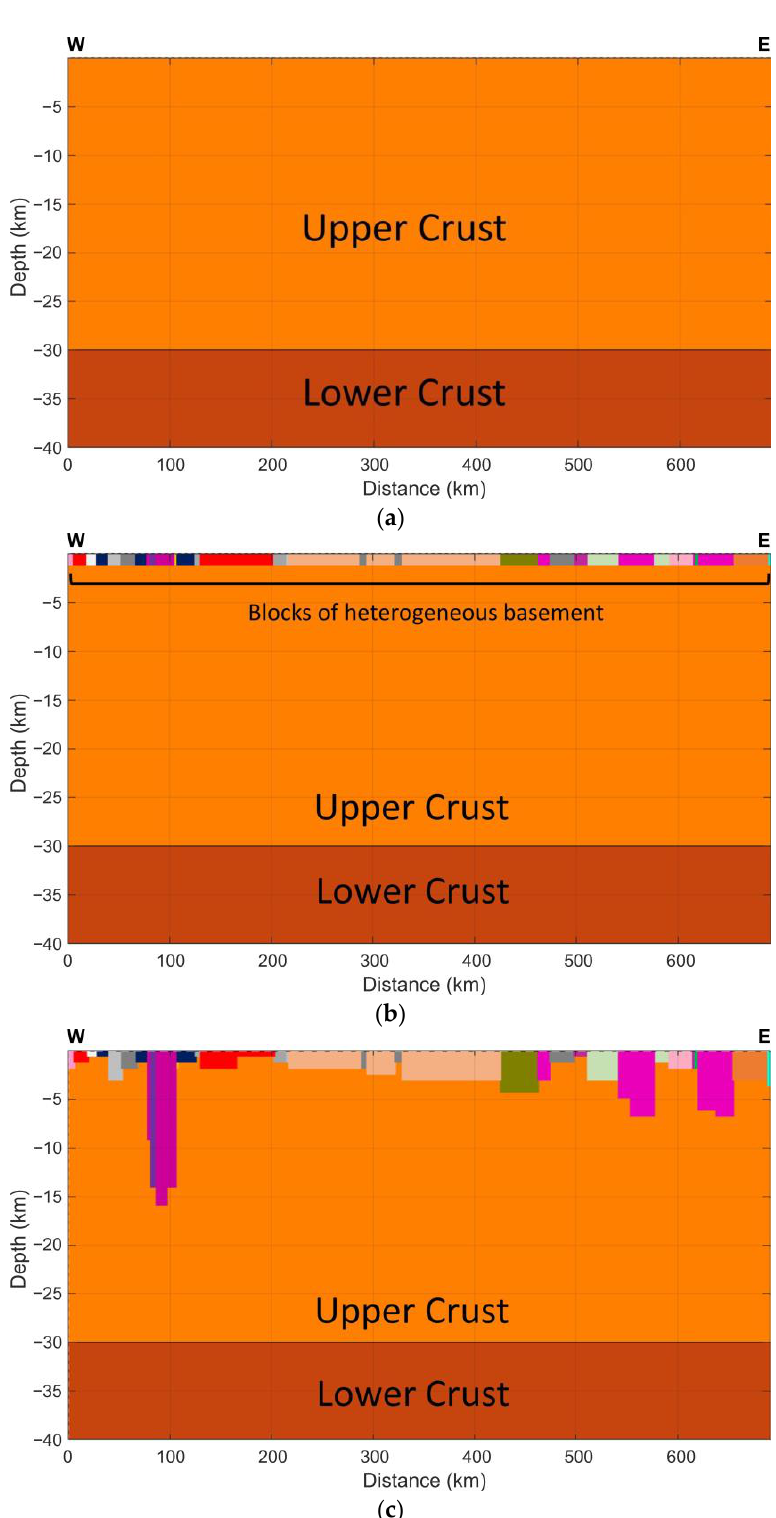
Figure 2. Initial state of the basin configuration before sedimentation at 251 Ma: ( a ) Model 1; ( b ) Model 2 with the preliminary assumption of the heterogeneous basement (Figure 1b) being 1 km thick; ( c ) Model 2 with the thickness of the heterogeneous basement determined by gravity analysis. Coloured blocks correspond to the heterogeneous basement with assigned petrophysical properties from Table 1. The layer of the lithospheric mantle is not displayed for the convenience of presenting the picture.